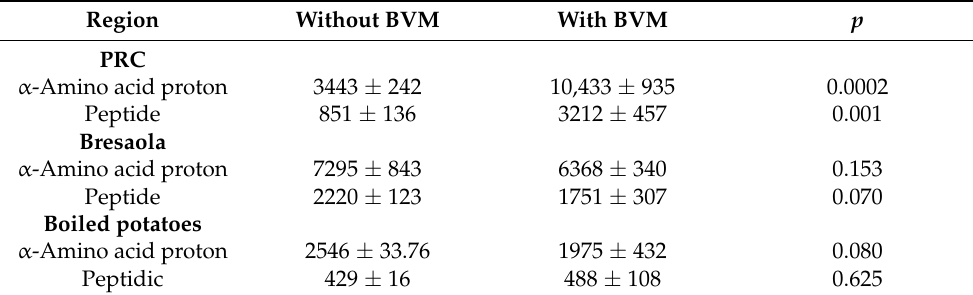
Table 3. Differential integral area ( ∆ 4D–1G) of α -amino acid and peptide proton regions of in vitro digested PRC, Bresaola, and boiled potatoes. All data are means ± SD of at least three independent in vitro digestions. Statistical analysis was by Student’s t